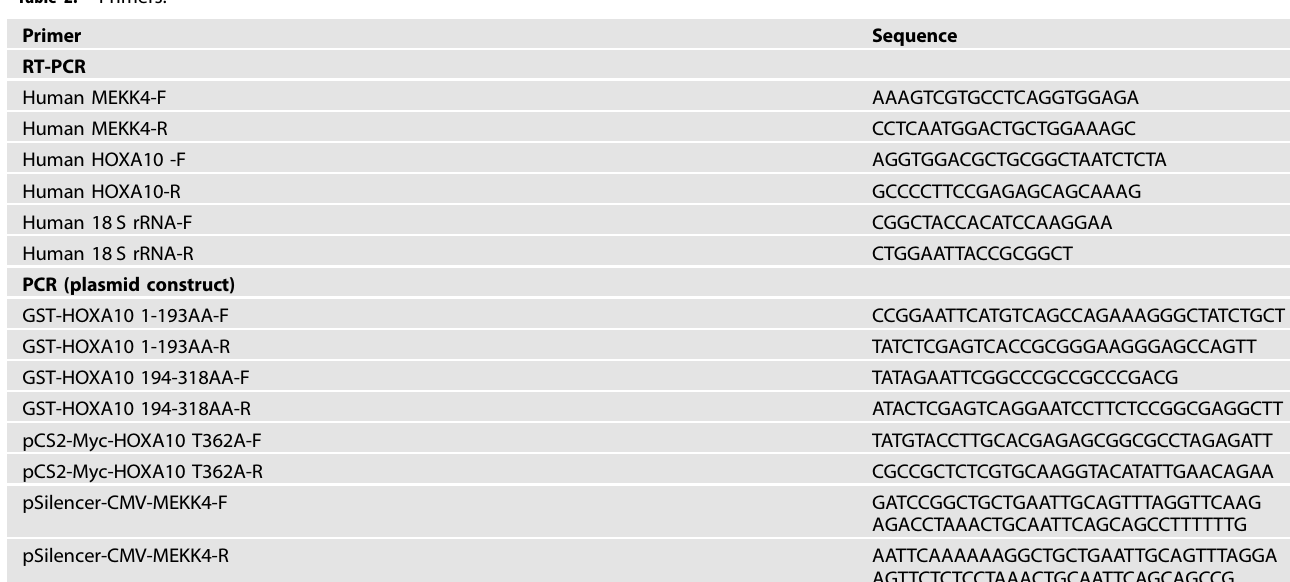
Table 2. Primers.